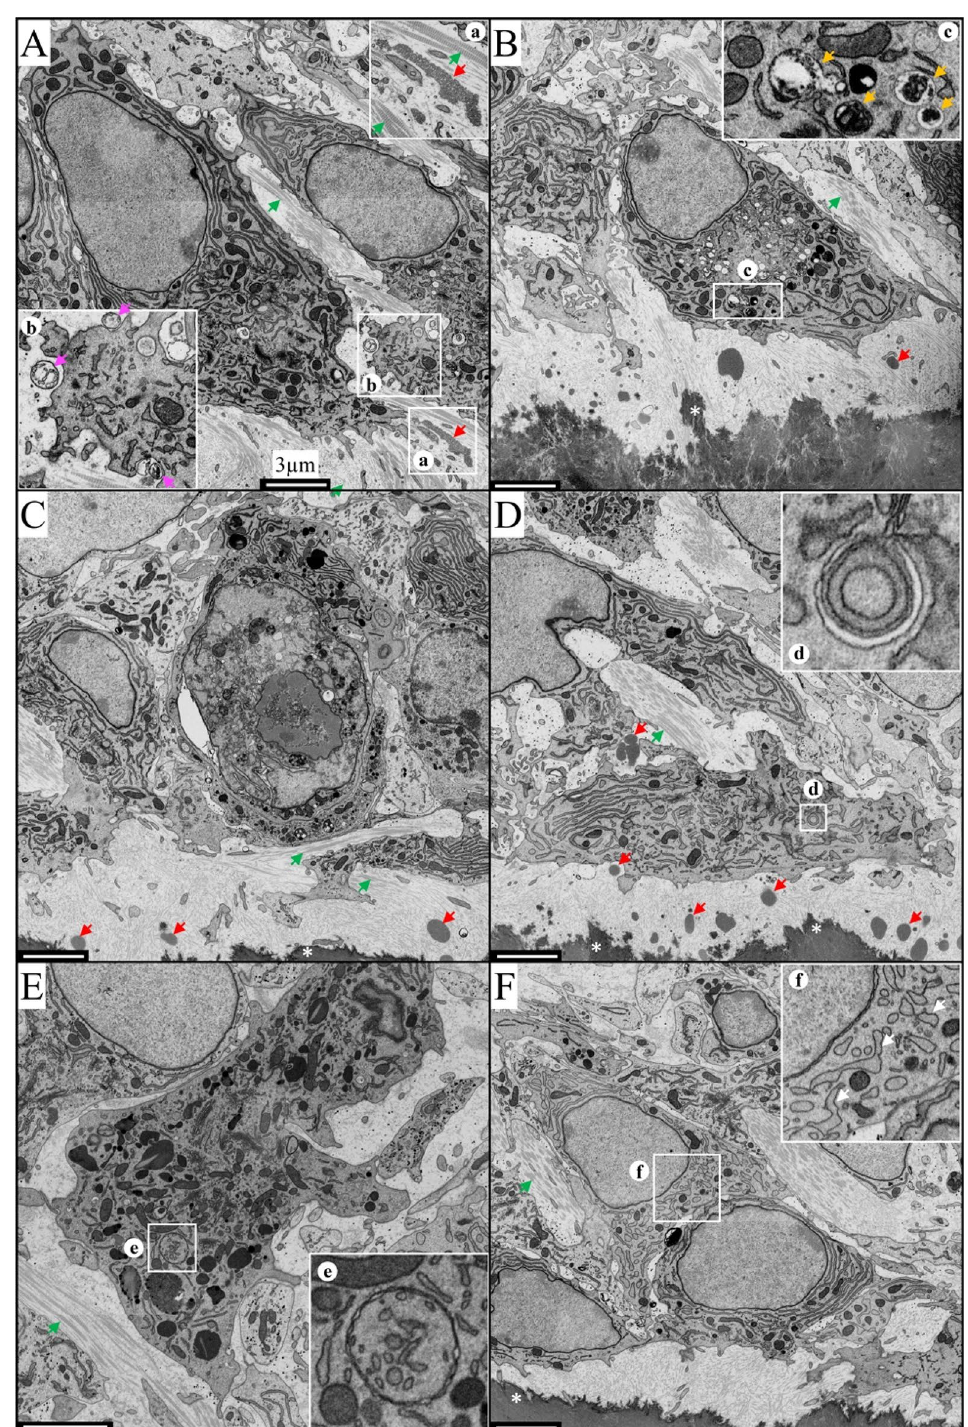
Figure 2. 10,000 × FIB-SEM of a 7-week-old Dspp −1fs/−1fs incisor showing odontoblast pathosis and apoptosis. (See Figure S2 for area sampling locations; see Fig. 1 and S1 for WT comparisons.) ( A ) (area -1) Odontoblasts prior to the onset of dentin mineralization were rich in endoplasmic reticulum (ER) and mitochondria and already separated by wide intercellular spaces, exposing collagen bundles (green arrows). Medium-density protein aggregates (red arrow inset ( a )) were observed in pre-dentin and extracellular vesicles (magenta arrows inset ( b )) containing fragmented cisternae were evident. ( B ) (area 0) Pathological odontoblasts show numerous intracellular degradative vacuoles, intercellular collagen bundles (green arrow) and extracellular medium-density plaques (red arrows). Existing pre-dentin mineralizes (*) but new pre-dentin is not deposited and thins. Vacuoles (orange arrows inset ( c )) contained cytoplasmic material in various stages of degradation. ( C ) (area S1) Apoptotic odontoblast with intranuclear vacuoles, nuclear destruction, and severe cytoplasmic pathosis. ( D ) (area S1) Extracellular medium-density plaques (red arrows) in pre-dentin and between odontoblasts. ( d ) Autophagosome with two layers of limiting membranes and an electron-lucent cisterna. ( E ) (area S2) Degenerating odontoblast. ( e ) A double-membrane-bounded vesicle containing fragmented ER. ( F ) (area S3) Odontoblast-like cells. ( f ) Swelling ER (white arrows). Scale bars: 3